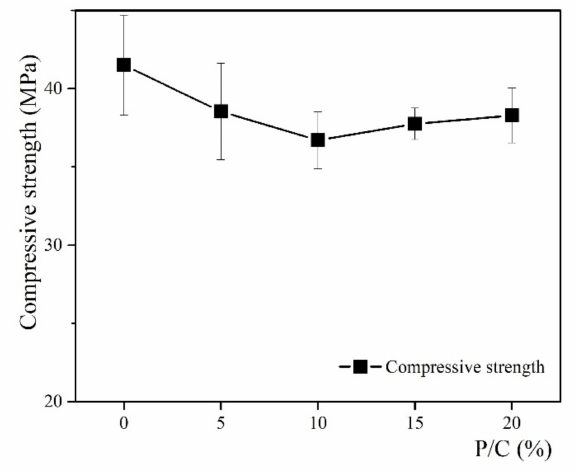
Figure 3. Compressive strength of the SBR latex-modified cement paste at 28 days.